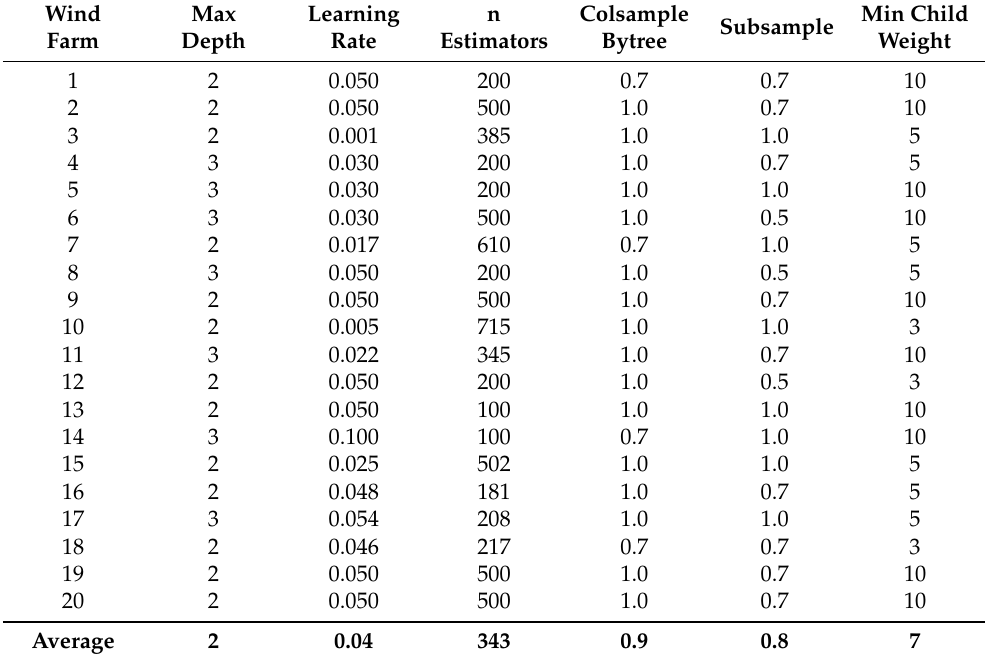
Table 4. Best XGBOOST hyperparameters for each wind